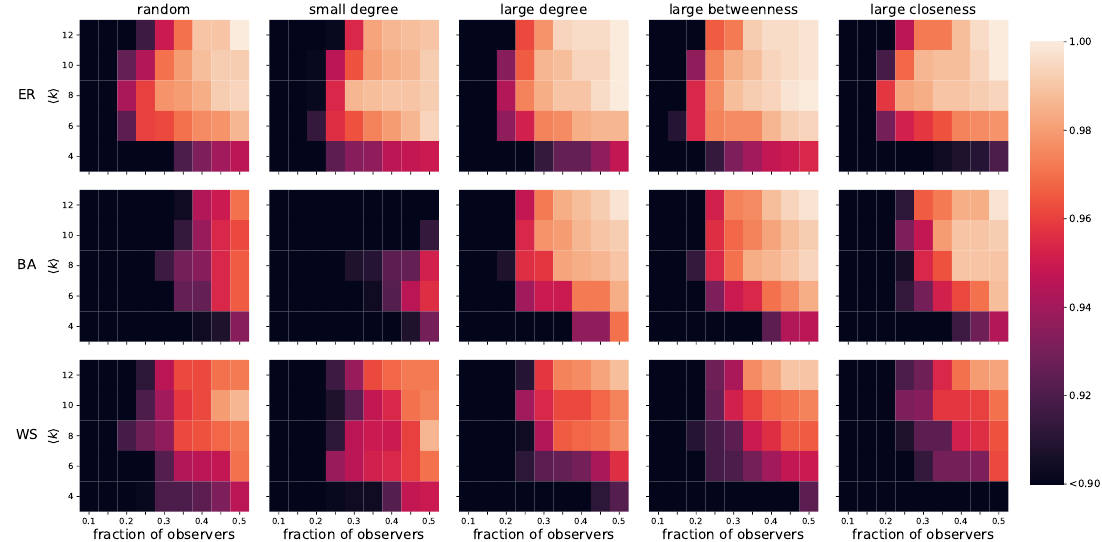
Figure 10. γ %-accuracy of GLAD-modified on three types of synthetic networks under different observer placement strategies with signal-to-noise ratio µ / σ = 4. The number of nodes is 100 in all networks, and the rewiring probability in WS is